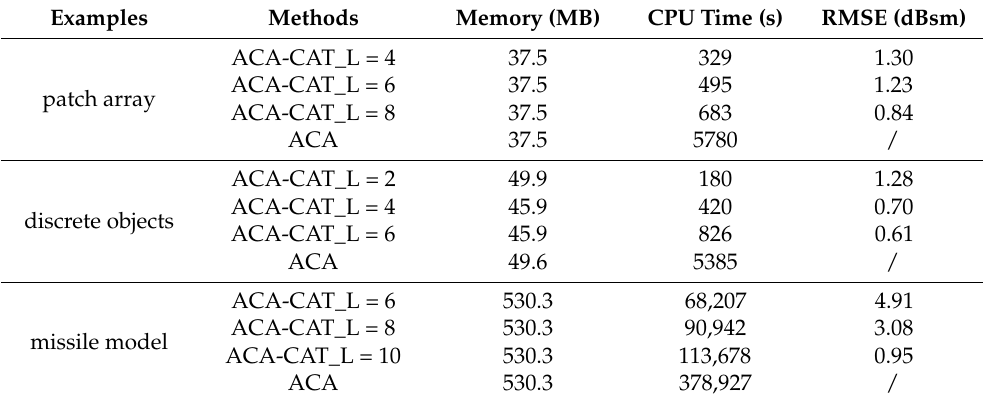
Table 1. CPU time, memory requirements and RMSE of ACA-CAT for wideband RCS simulation of three examples at different